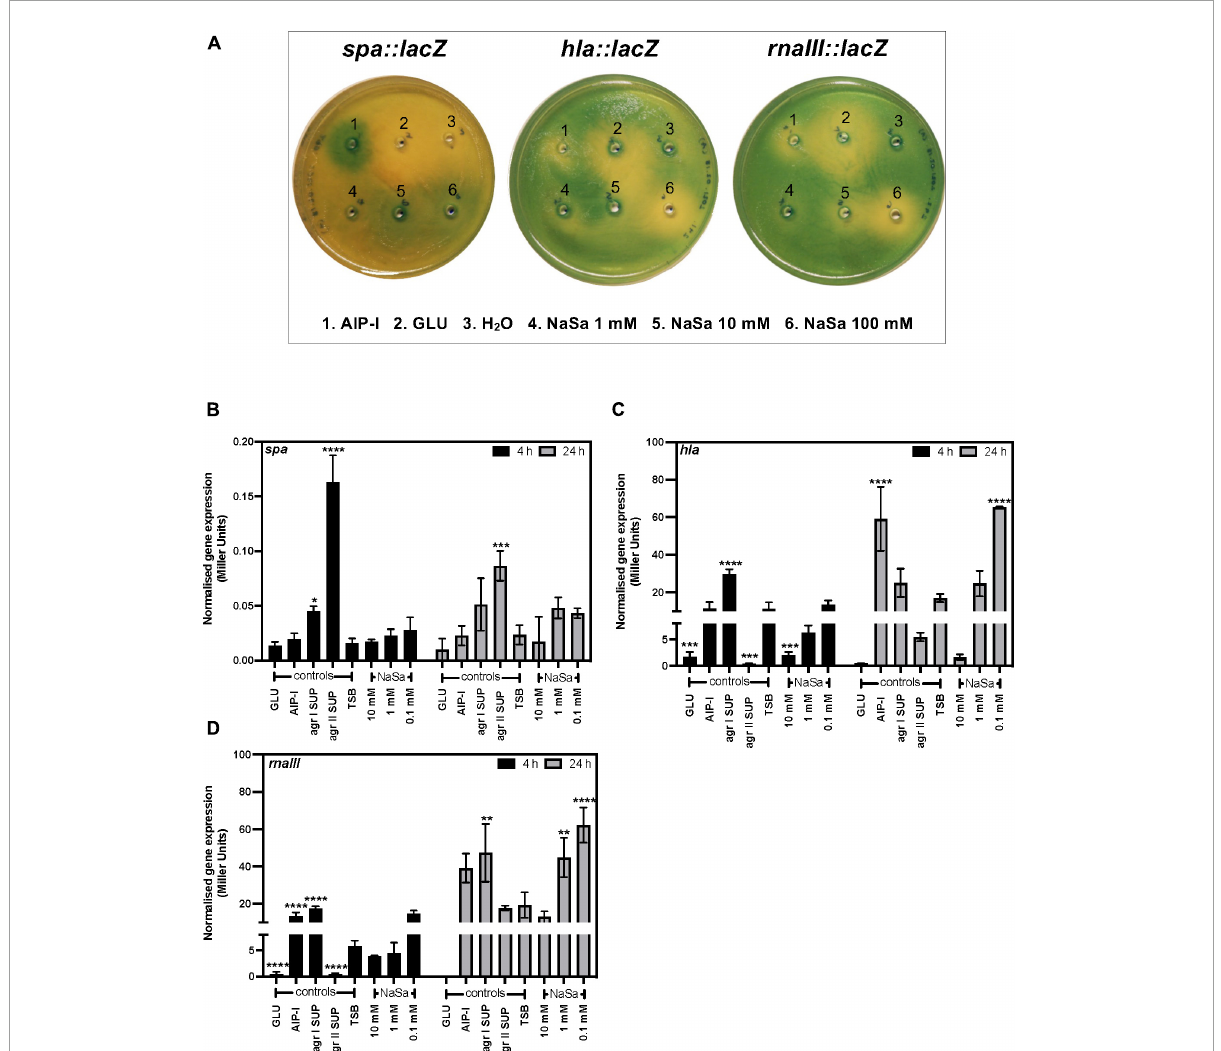
FIGURE4 NaSa modulates the expression of spa, hla and rnaIII. Effect of NaSa on the β -galactosidase activity of S. aureus reporter strains 8325-4 spa::lacZ, 8325-4 hla :: lacZ, and 8325-4 rnaIII :: lacZ in X-gal-containing agar plates after 24 h (A) or the ONPG assay after 4 and 24 h (B–D) . Each bar represents the mean ± SD from three independent experiments. * P ≤ 0.05, ** P ≤ 0.01, *** P ≤ 0.001, **** P ≤ 0.0001, statistically significant to TSB (Tryptic Soy Broth) as media using one-way ANOVA Dunnett’s test. GLU, glucose; AIP-I, Autoinducing Peptide-I; SUP, supernatant; ACN, acetonitrile, used as AIP-I diluent